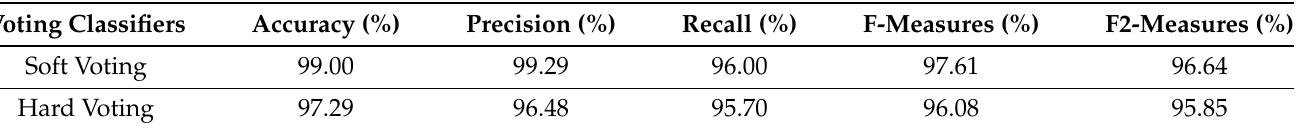
Table 3. Evaluation results of ensemble voting after pre-processing, using method 1.